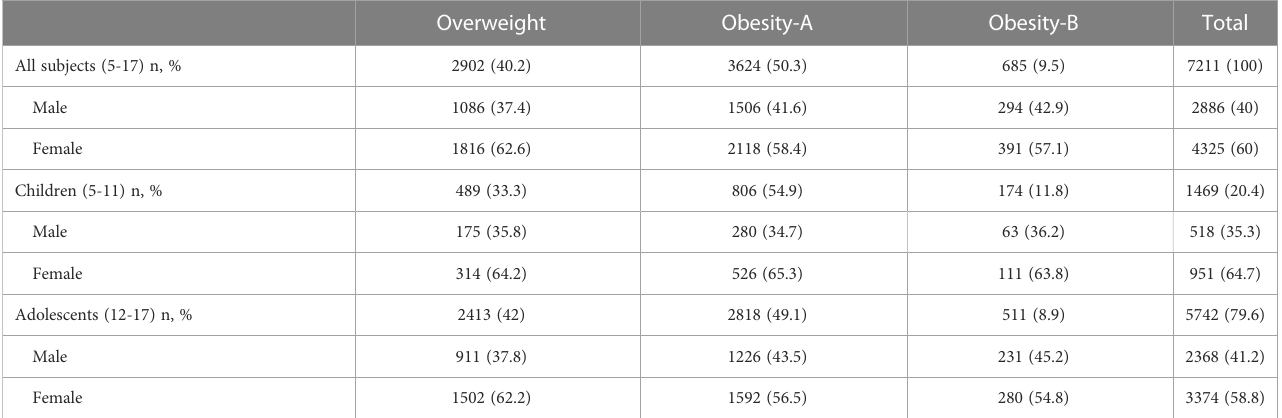
TABLE 2 Distribution of weight groups by age and sex.